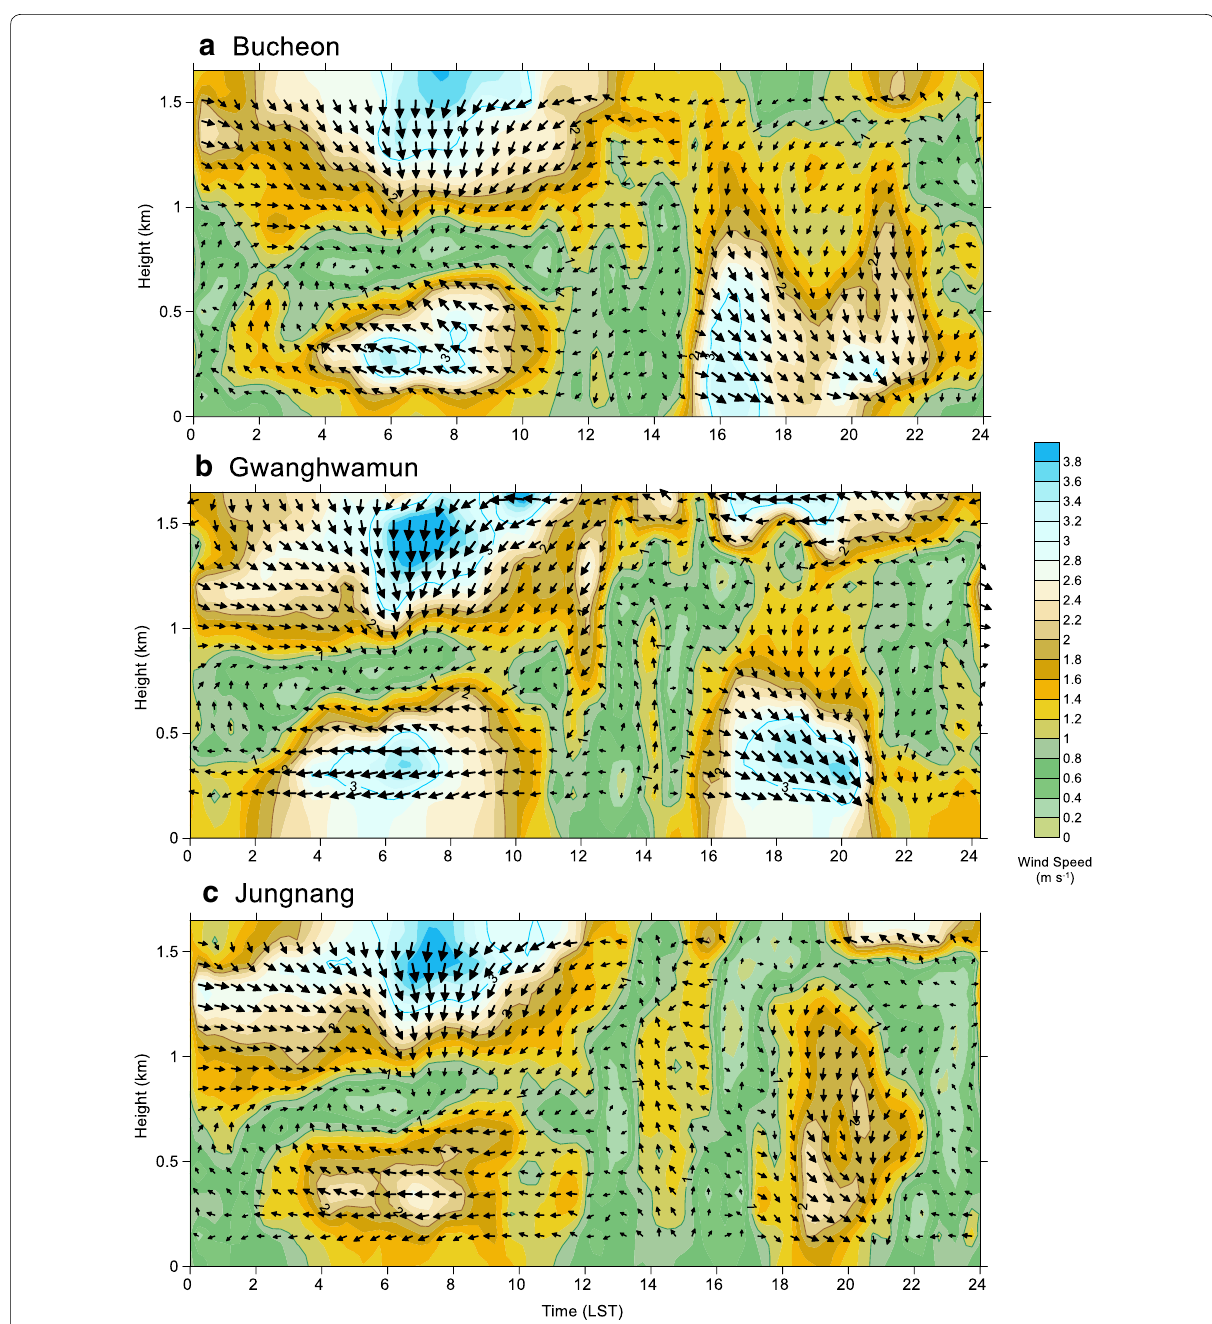
Fig. 7 Time–height cross sections of wind speed (contour, arrow size) and direction (arrow) obtained by wind lidar averaged over 6 consecutive days from 17 to 22 May 2016 at a Bucheon, b Gwanghwamun, and c Jungnang